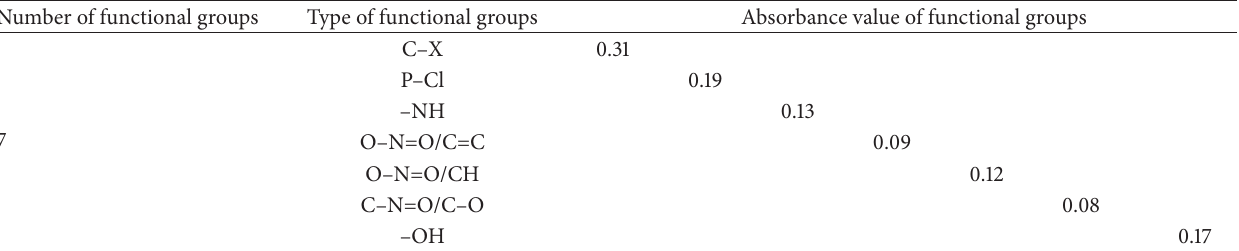
Table 1: The database table design of S1